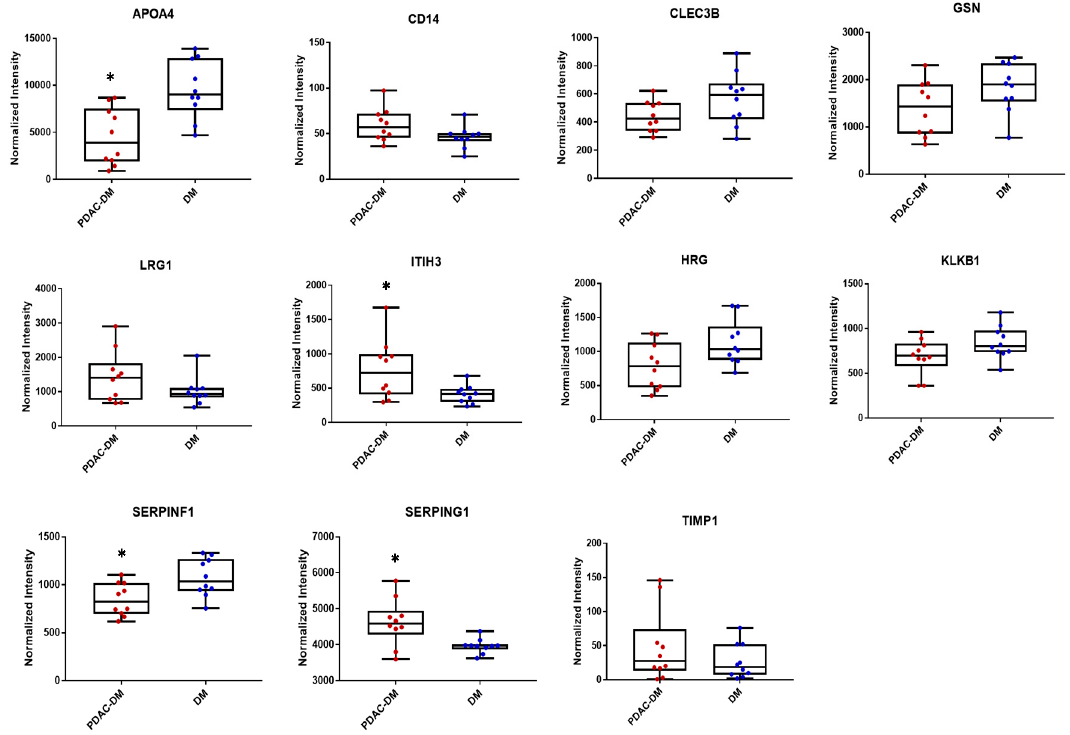
Figure 2. Measurements of the 11 protein candidates in the plasma samples of the pilot cohort, which includes 10 PDAC-DM (left) and 10 DM (right); * p ≤ 0.05.